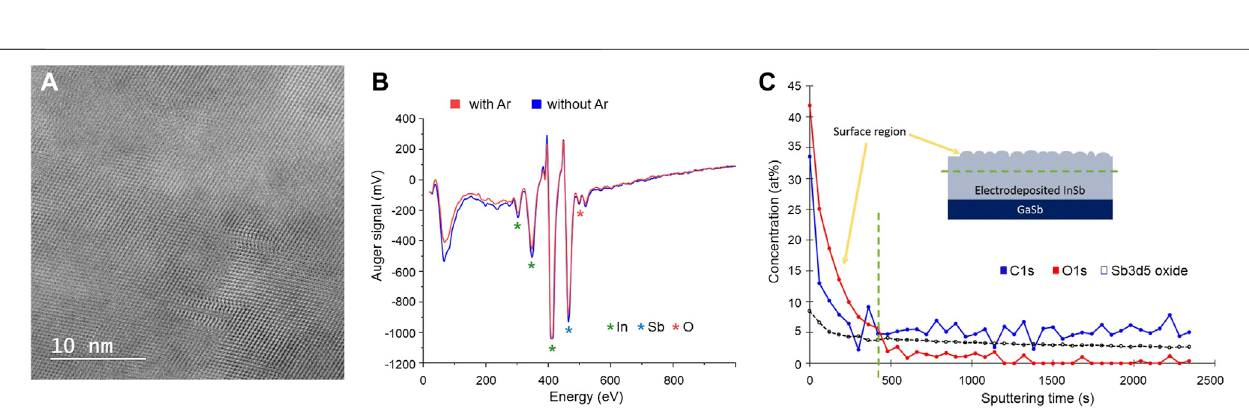
FIGURE4|(A) High-resolution(S)TEM imageofInSbafterannealingprocess. (B) Augerspectraforsampleselectrodepositedwith(blue)and without(red)oxygen dissolved in the electrolyte, respectively. (C) XPS depth pro fi le of impurities [O (red), C (blue), and Sb oxide (black)] concentration (at%) distribution in electrodeposited InSb. Sputtering time is directly correlated with the thickness of the deposit. A green dotted line marks the surface region with indicates the presence of electrolyte residues and surface oxides.